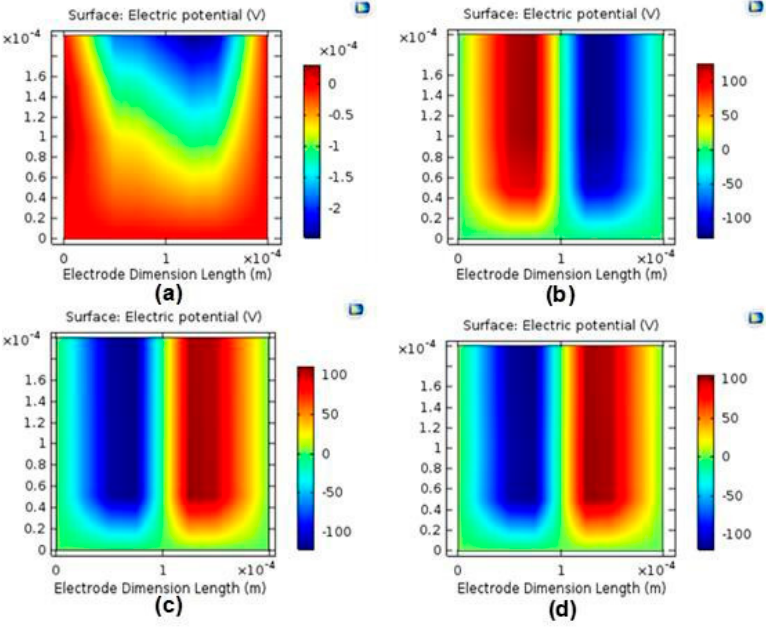
Figure 4. Electron field across the surface of the terminal and ground electrodes for increasing terminal voltage: ( a ) 500 V ( b ) 1500 V ( c ) 4000 V ( d ) 8000